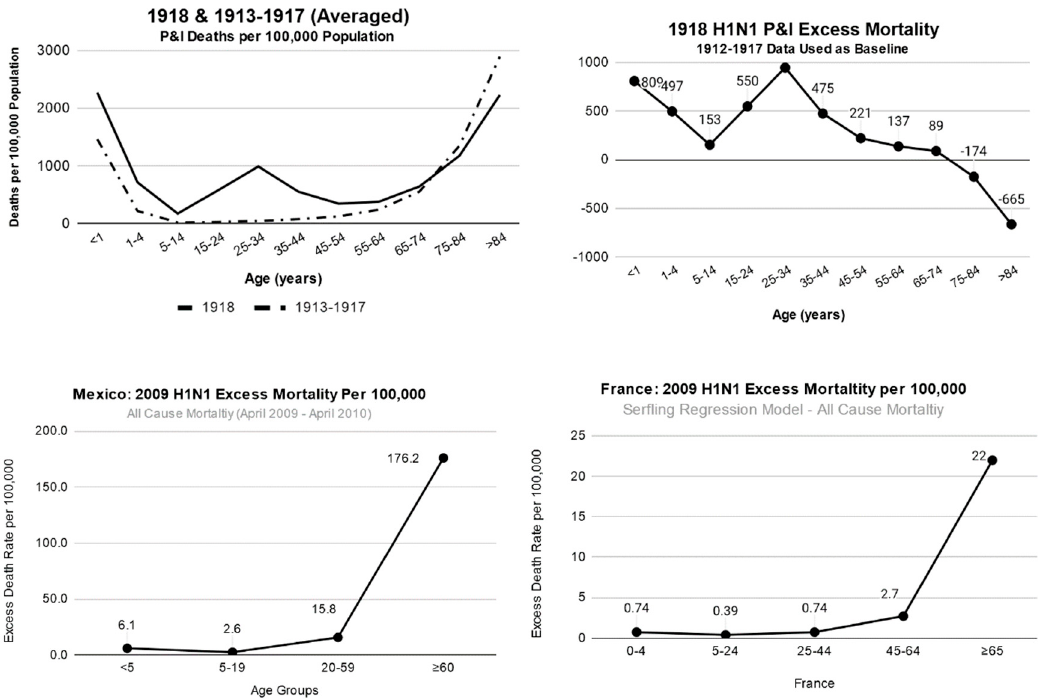
Figure 2. Mortality visualizations for H1N1 pandemics of both 1918–1919 and 2009. Averaged mortality (upper left) as compared to excess mortality (upper right) due to 1918 H1N1 pneumonia and influenza (P&I) pandemic. Excess death rates [5] are shown for the 2009 H1N1 pandemic for both the country of Mexico (lower left) [38] and France (lower right) [39].